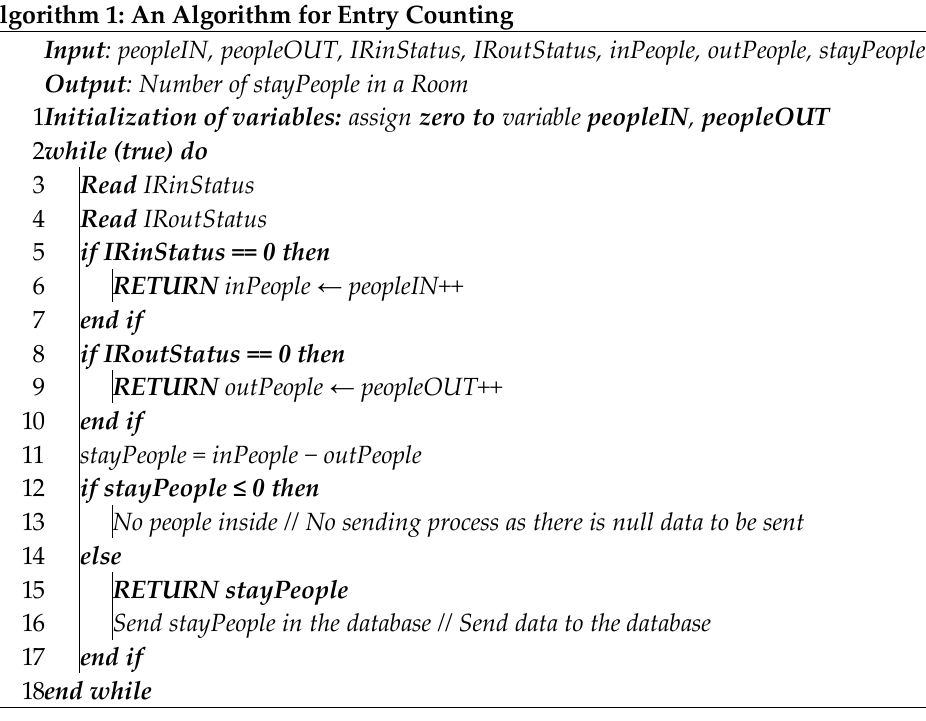
Figure 5. Deployment design of building monitoring IoT system. The system consisted of multiple nodes deployed in different rooms or locations to monitor selected environmental parameters, including temperature, humidity, CO 2 , motion, and occupants. The end nodes were equipped with various sensors (such as humidity, temperature, CO 2 , motion, and RIF sensors) and connected to the manager (centralized controller) to ensure connectivity with deactivation in case of poor